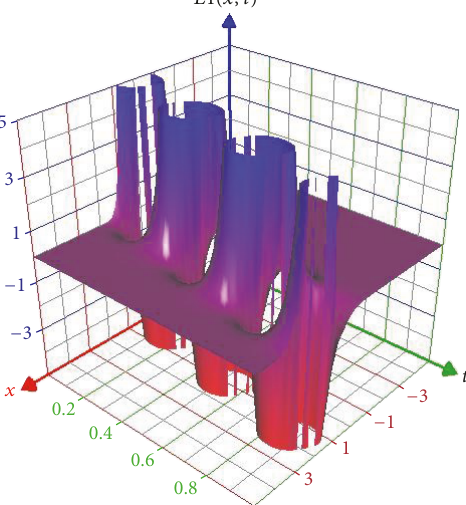
Figure 1: The solitary wave of the real part of 𝐸 1 (𝑥,𝑡) in (23) for −5 ≤ 𝑥 ≤ 5 , 0 ≤ 𝑡 ≤ 1